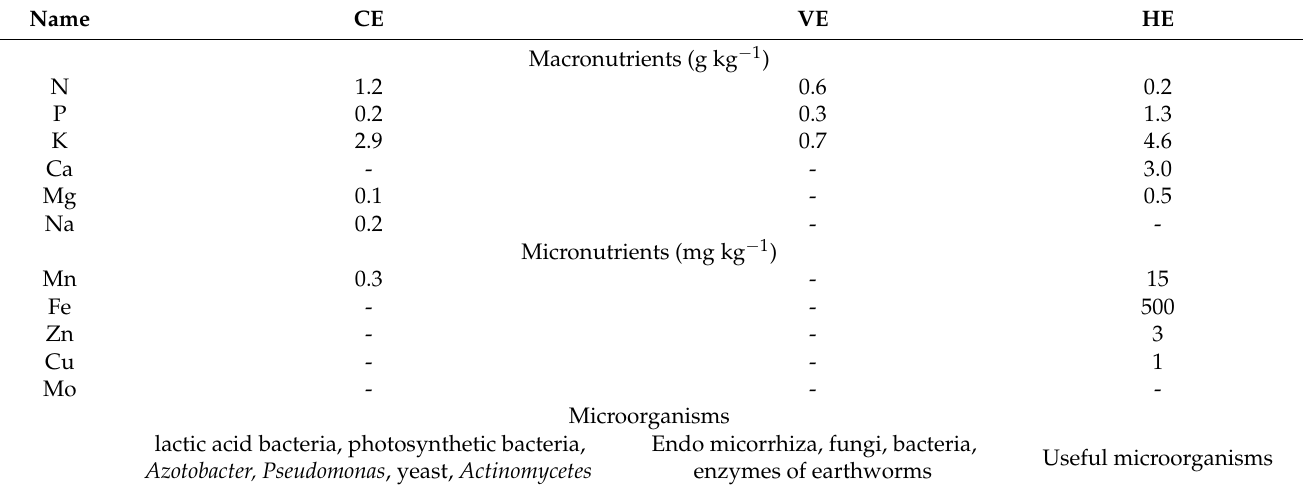
Table 1. Soil conditioner composition based on manufacturers’ data.